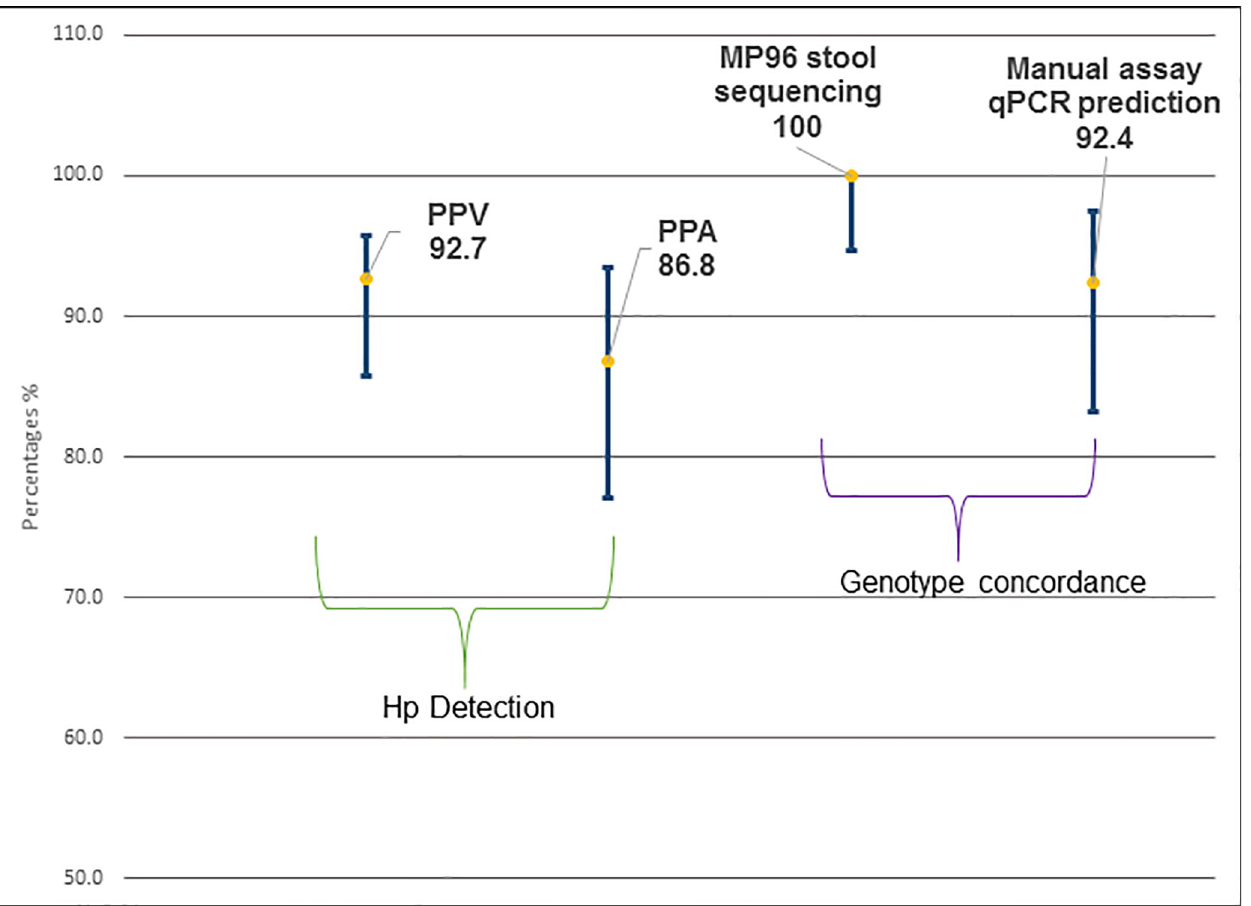
Fig 2. PPA and PPV results of MP96 stool assay compared to the reference manual stool assay of the same stool specimens for Hp detection; genotype concordance of the MP96 stool assay to sequencing and manual assay qPCR prediction.